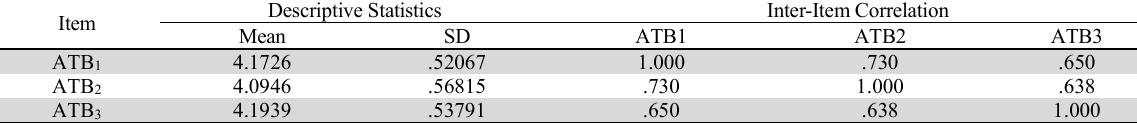
ATB Validity and Reliability